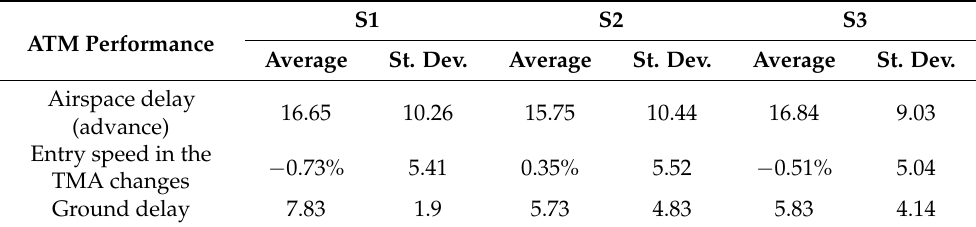
Table 8. ATM performance for scenarios S1, S2 and S3.